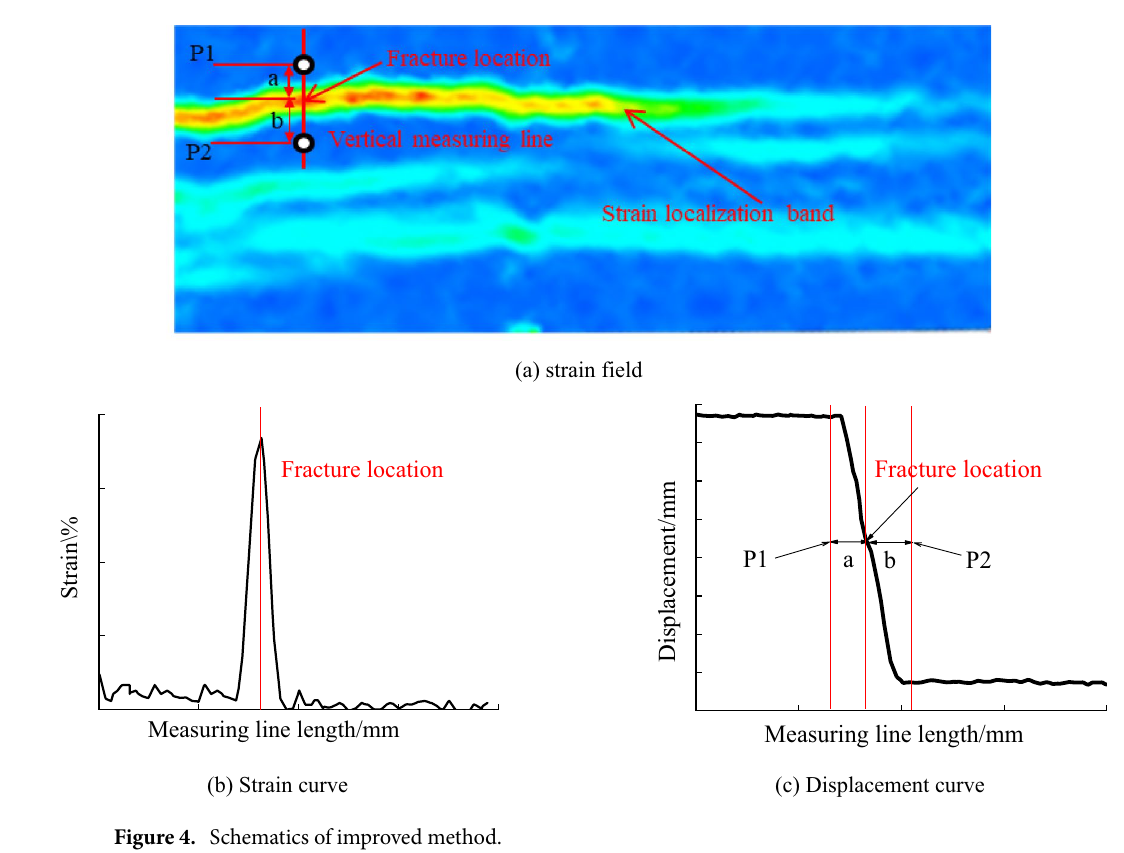
Figure 4. Schematics of improved